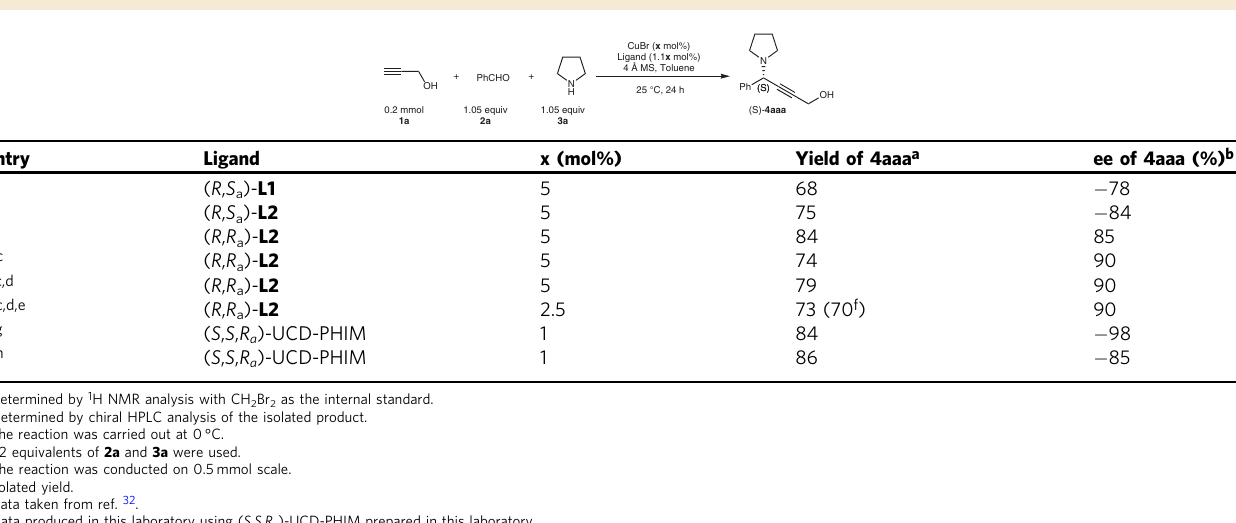
Table 1 Optimization of the reaction conditions.